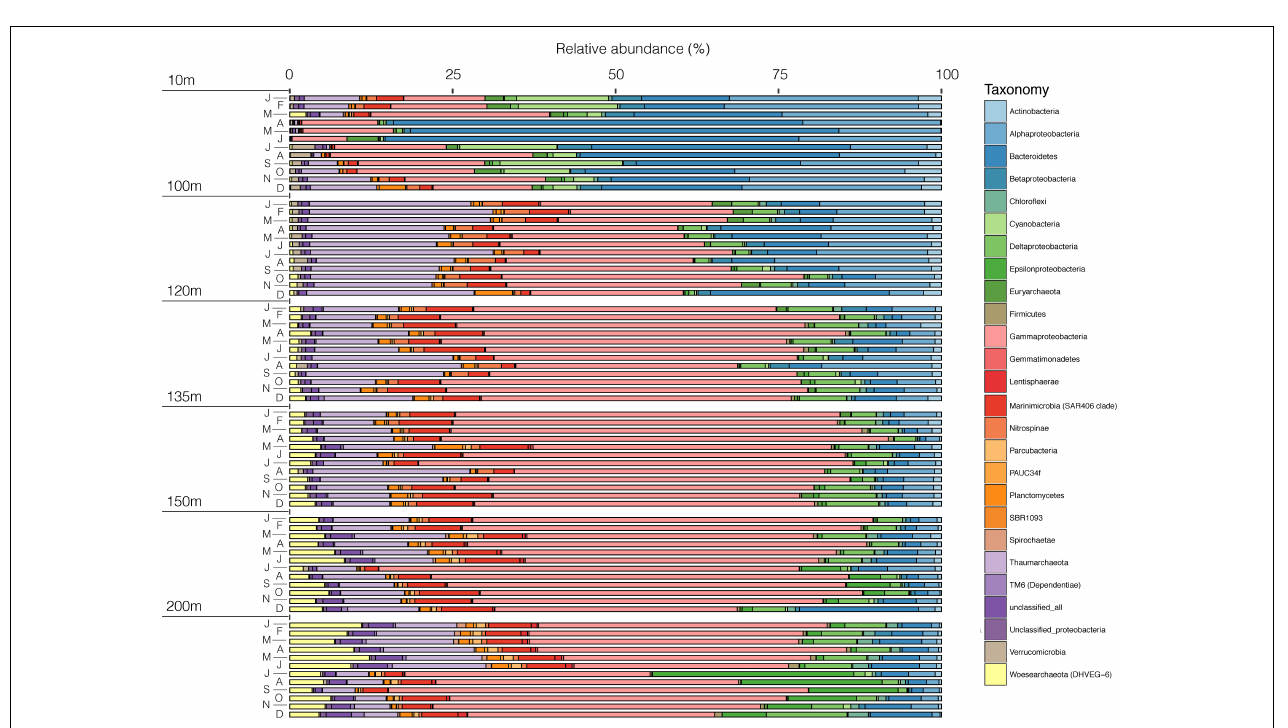
FIGURE 6 | Integrated N-loss rates over the year through denitrification in orange and through anammox in blue. The black dotted line represents the percentage of N-loss occurring through anammox (in %). The stacked bar represents the averaged N-loss over the entire year.